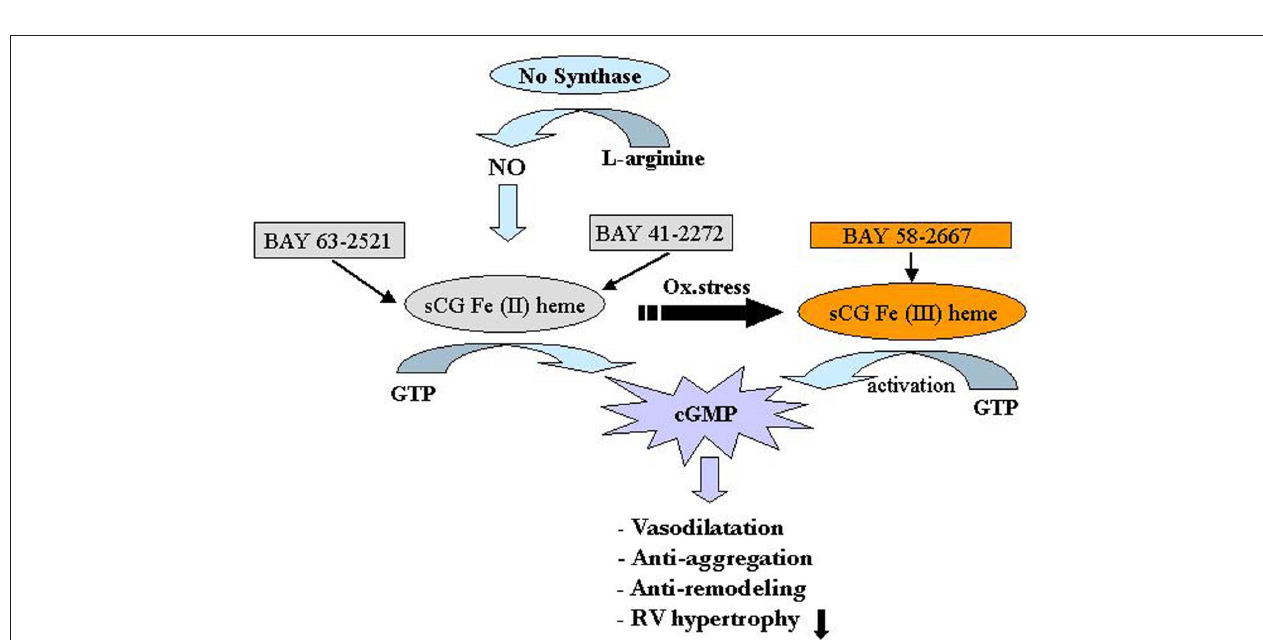
myosin light chain phosphatase; NO, nitric oxide; PDE-5, phosphodiesterase-5; VSMC, vascular smooth muscle cell; PGI , prostacyclin; PLC, phospholipase C; SR, 2 sarcoplasmic reticulum. Reproduced with permission from Fukumoto et al.